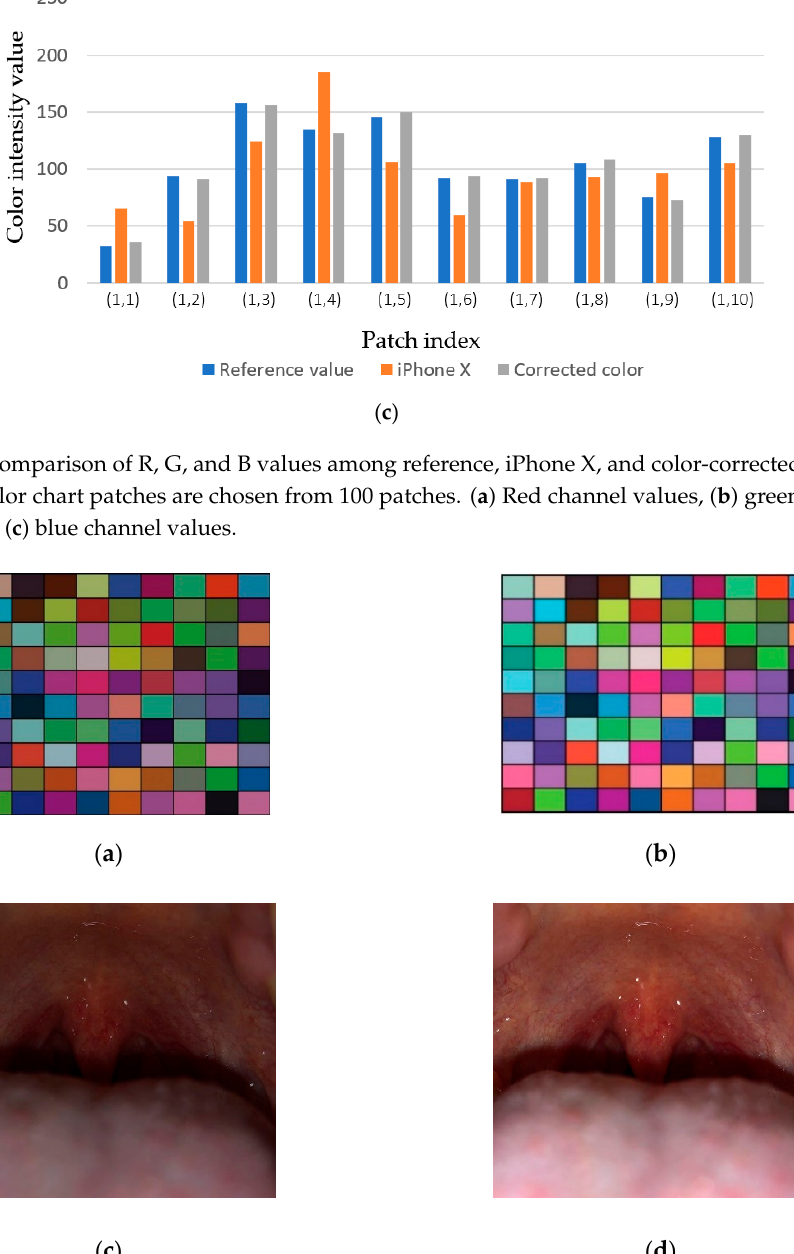
Figure 5. Output examples obtained by the color correction step of our proposed method. ( a ) Original image of the color chart, (b) corrected image of the color chart after applying our color corrected method, ( c ) original throat image which is presented by the color space in (a), and ( d ) color corrected throat image.